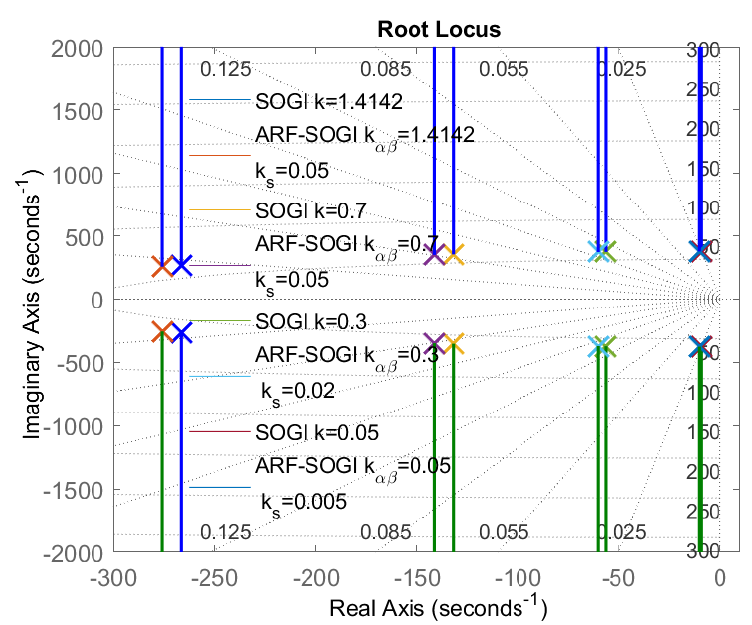
Figure 7. SOGI-QSG and ARF-SOGI-QSG low-pass filter qv (cid:48) poles. It is worth noticing that as stability is improved, the frequencies of interest are atten- uated while the bandwidth is reduced; however, it is possible to find a combination that is acceptable, where k s is not so small with respect to k αβ . It is recommended to select k s and k αβ values so that, in the unit-step test, the ARF-SOGI-QSG filters do not overshoot, in a similar manner to that of a critically damped system or to an over-damped system. This prevents large transient overshoots during phase jump disturbances and frequency deviations. As seen in Figures 8 and 9, when the value of k s tends to the value of k αβ , the ARF-SOGI-QSG poles are real and lie in the left half-plane, but one of the poles is approaching the imaginary axis. This implies that the system is over-damped (for instance, look at the poles when k s = k αβ = 1.4142).